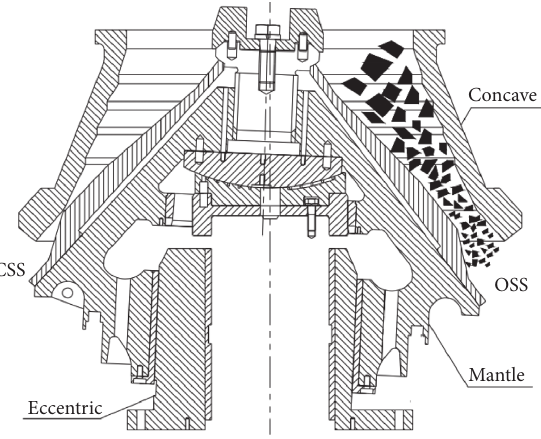
Figure 5: Cross section of cone crusher. Table 1: The structure parameters optimized by GA.